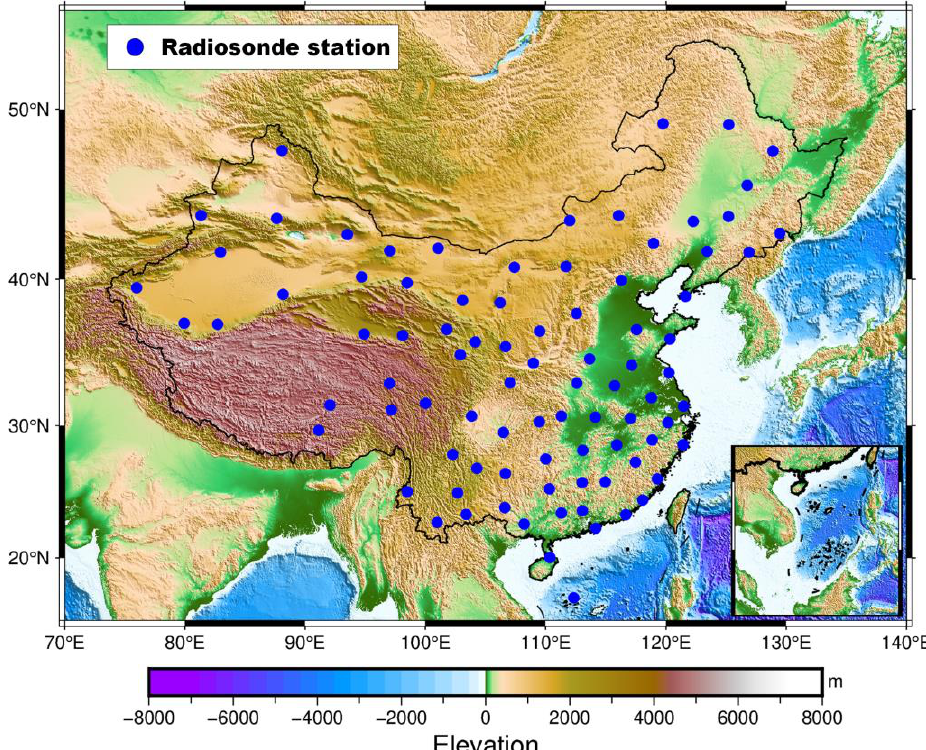
Figure 1. The geographic distribution of 88 selected radiosonde stations over China. The blue dots denote the locations of the radiosonde stations and the color on the map represents the elevation. The map is generated by Generic Mapping Tools [51], and the 2-min Gridded Global Relief Data (ETOPO2) v2 are used.